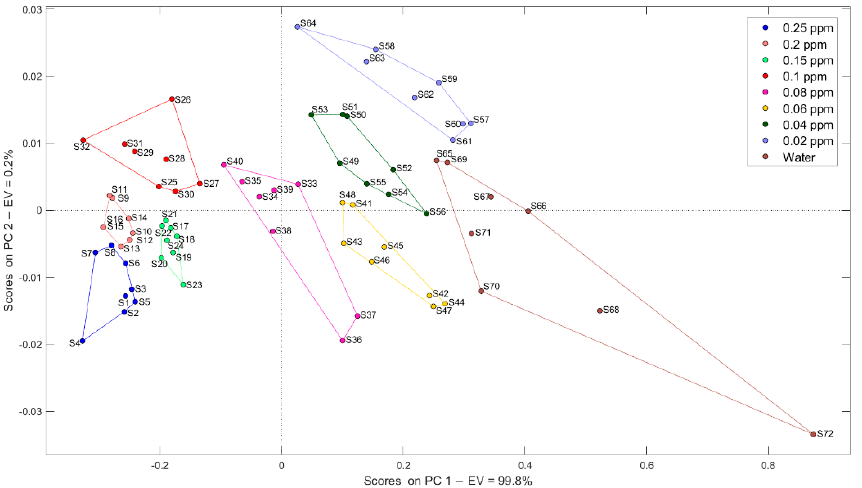
Figure 11. PCA plot using the carbon electrode (C110) to discriminate different Nativo pesticide concentrations against a distilled water solution.